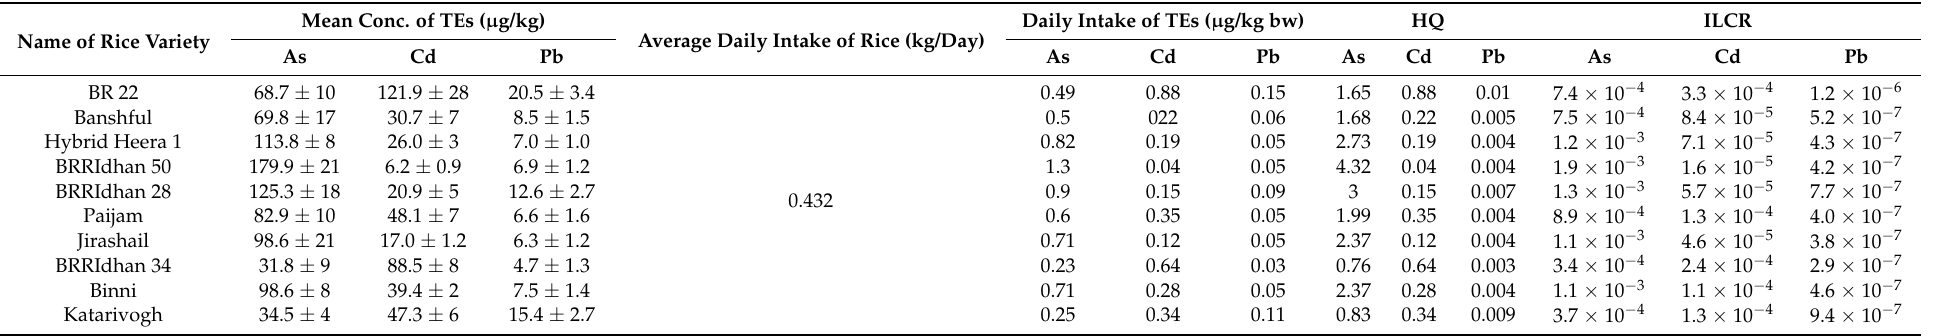
Table 5. Estimated daily intake of TEs (As, Cd, and Pb) from different brands of rice and the health risk for washing 5 times and a rice to water ratio of 1:6 (traditional methods of